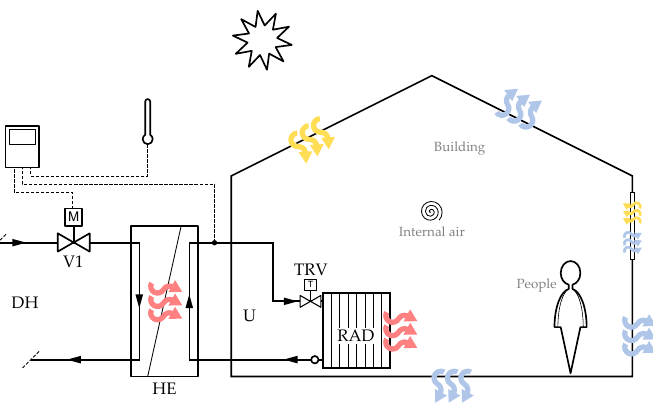
Figure 2. Schematic representation the heating system within the general